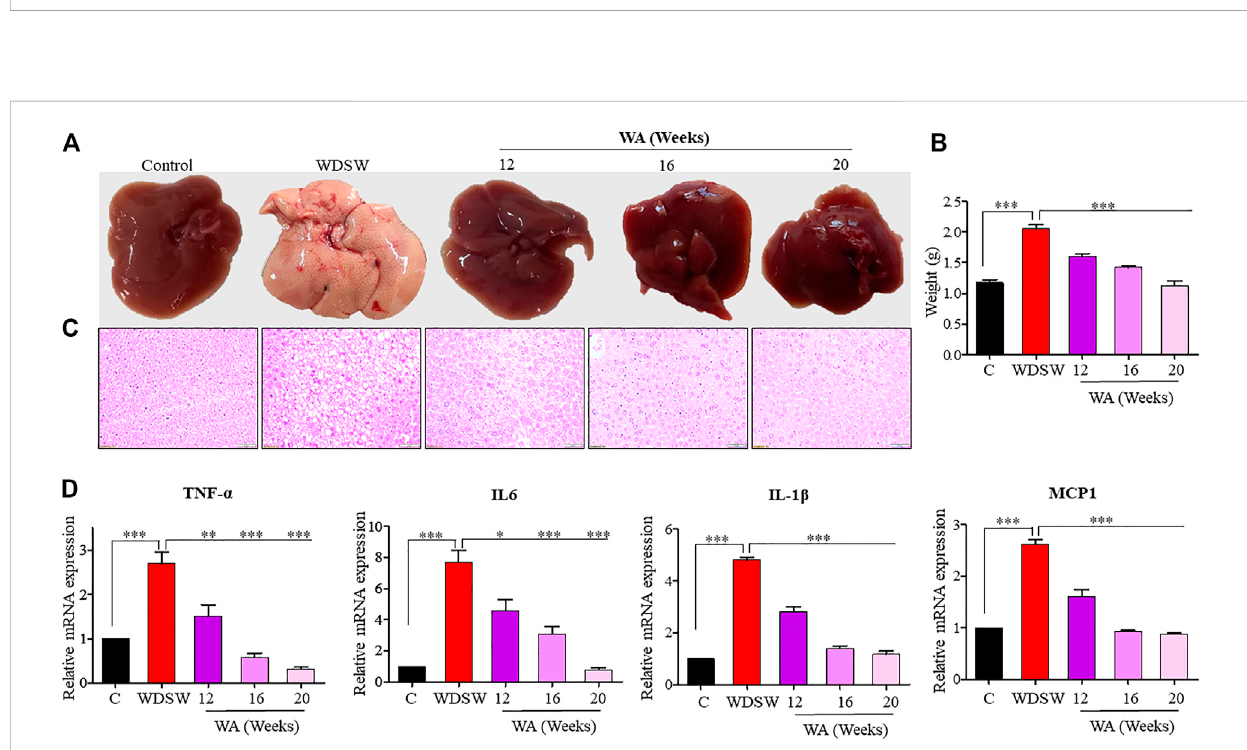
Withaferin A ameliorates steatosis and steatohepatitis both in vivo . (A,B) Representative images and graphs depicting a reduction in fat accumulation in the liver and liver weights in a withaferin A-treated WDSW-induced NAFLD mouse model. (C) Representative liver sections stained with hematoxylin-eosin (H&E) with a scale bar of 50 μ M. (D) Relative mRNA expression levels of TNF- α , IL-6, IL-1 β , and MCP1 were evaluated in the